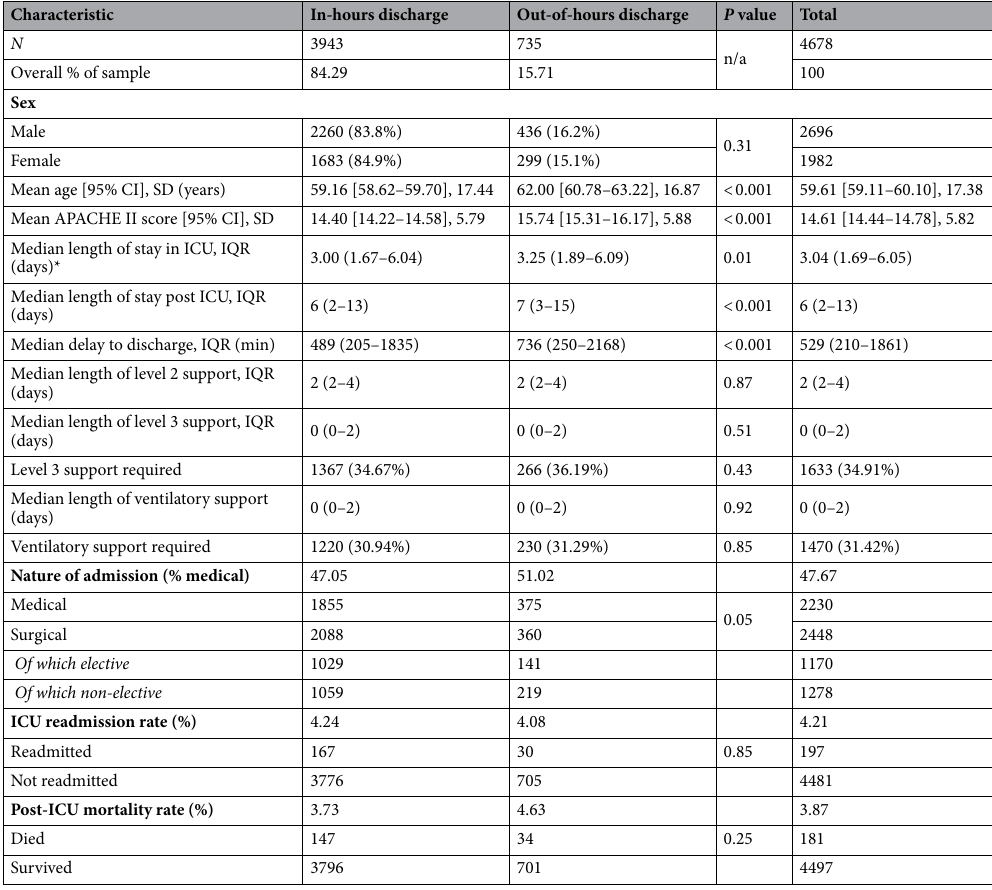
Table 1. Characteristics of patients discharged from the intensive care unit (ICU) after exclusion of end-of-life patients, over a 3-year period. *Data for this variable recorded to 2 decimal places. Data compared by Mann– Whitney U or Chi-square tests as